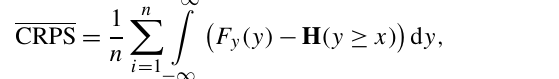
model cycle for certain days for the last 20 years. The re- forecast obtained for this study was produced with model cycle 43r1 (Buizza et al., 2017). The first forecast is on 10 March 1996 and the last forecast on 29 December 2015, with reforecasts alternating every 3 or 4